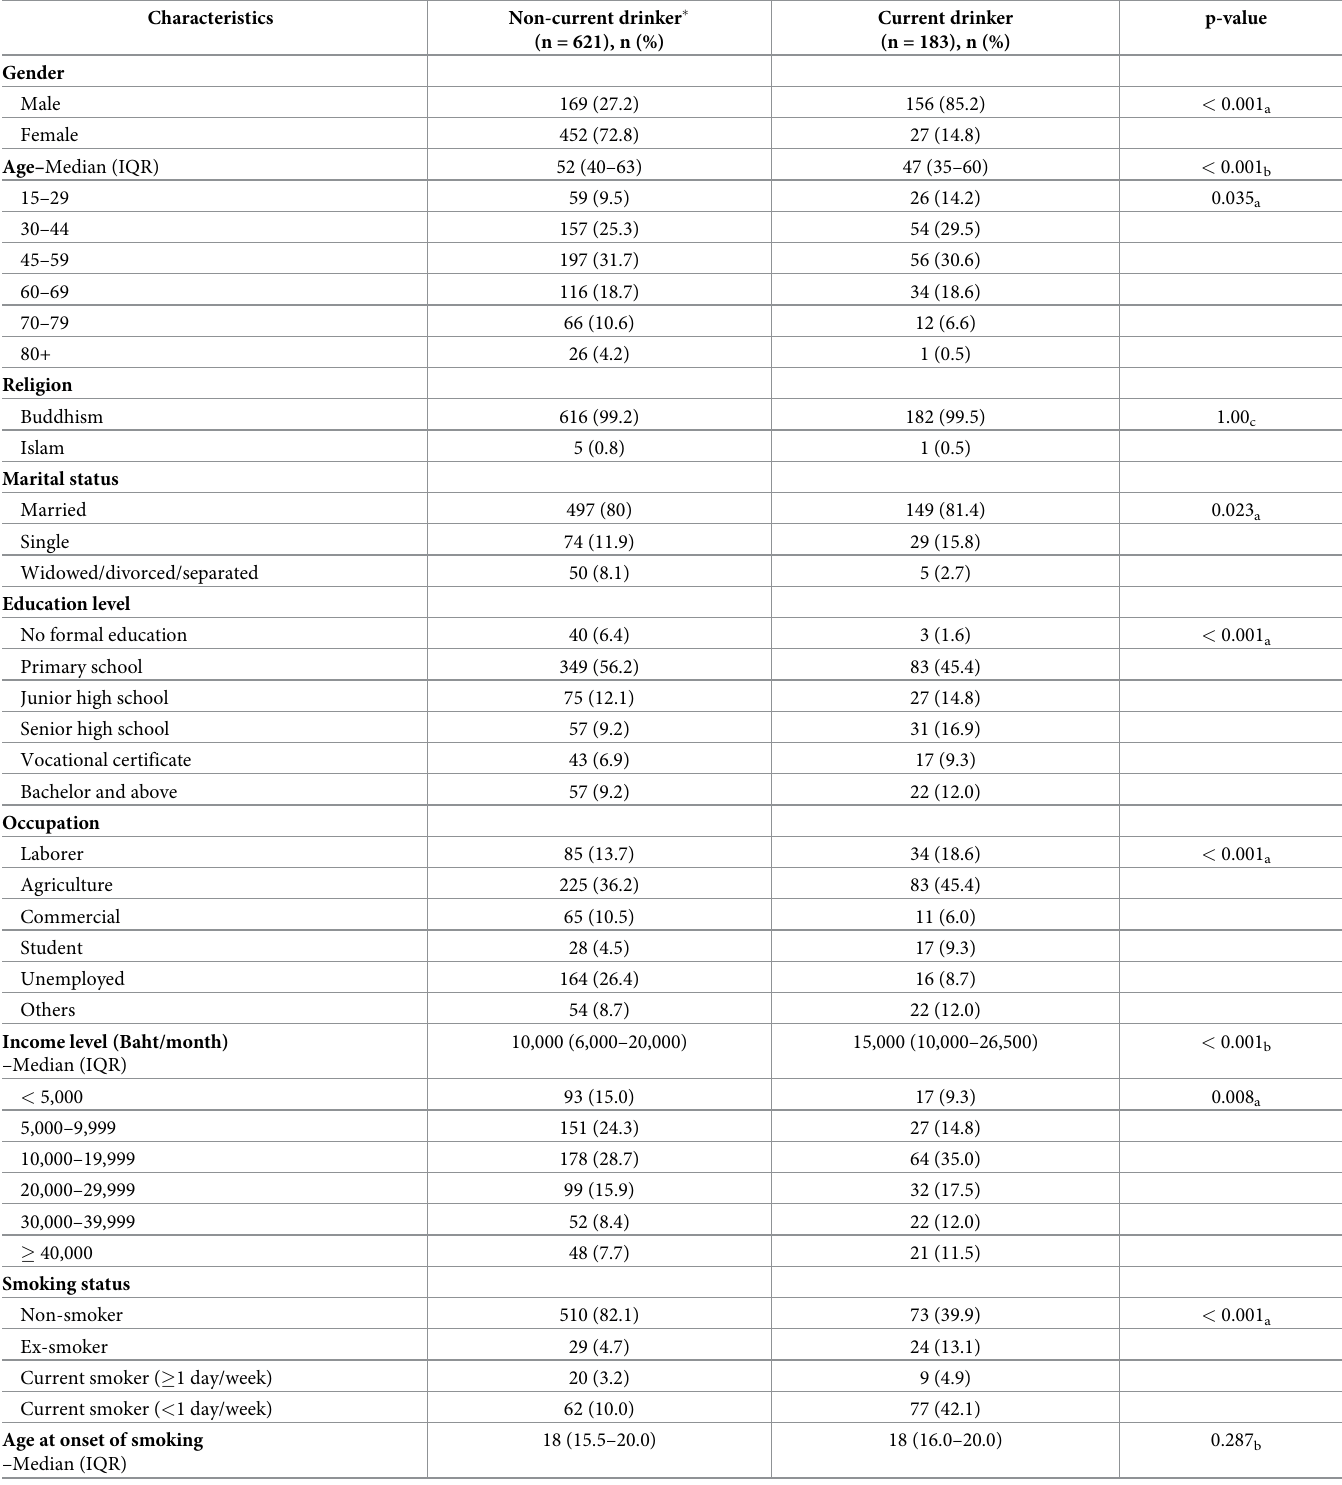
Table 2. Characteristics of the sample by drinking status (n =